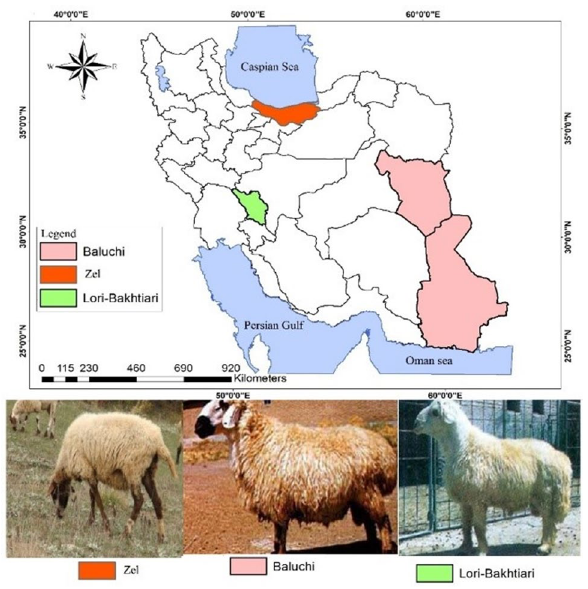
Figure 1. Traditional geographic distributions of the three Iranian sheep